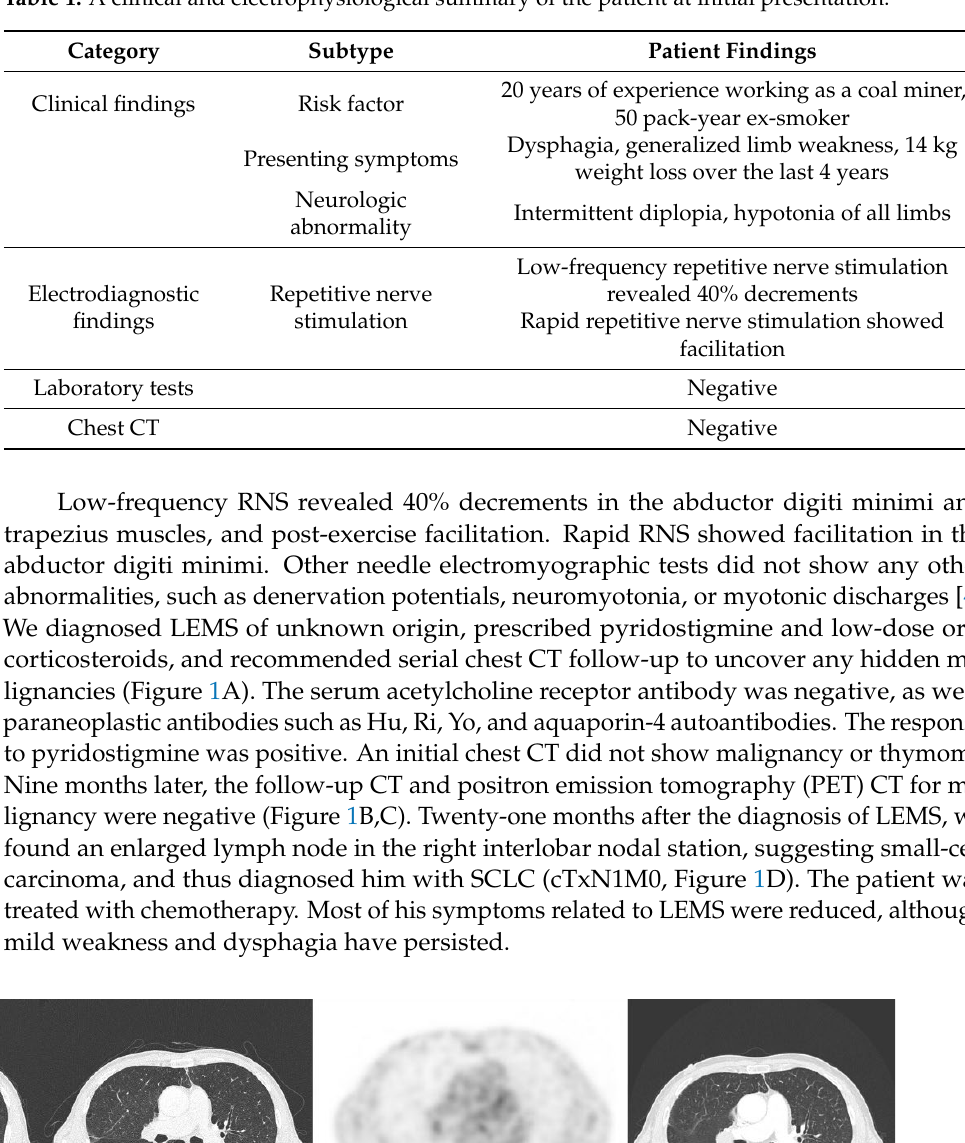
Table 1. A clinical and electrophysiological summary of the patient at initial presentation.